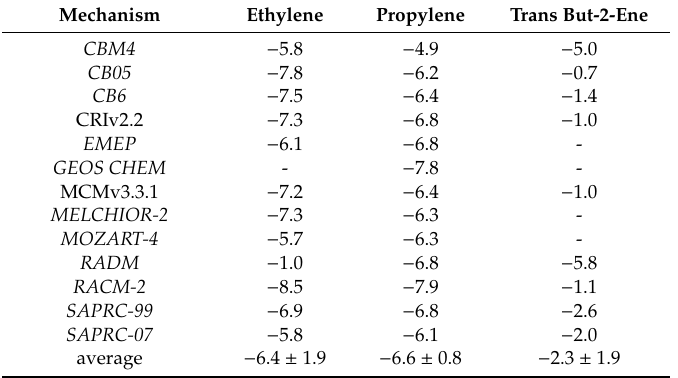
Table 4. Initial a hydroxyl radical incremental reactivities for the alkenes in units of 10 6 molecule cm − 3 per ppb hour − 1 .